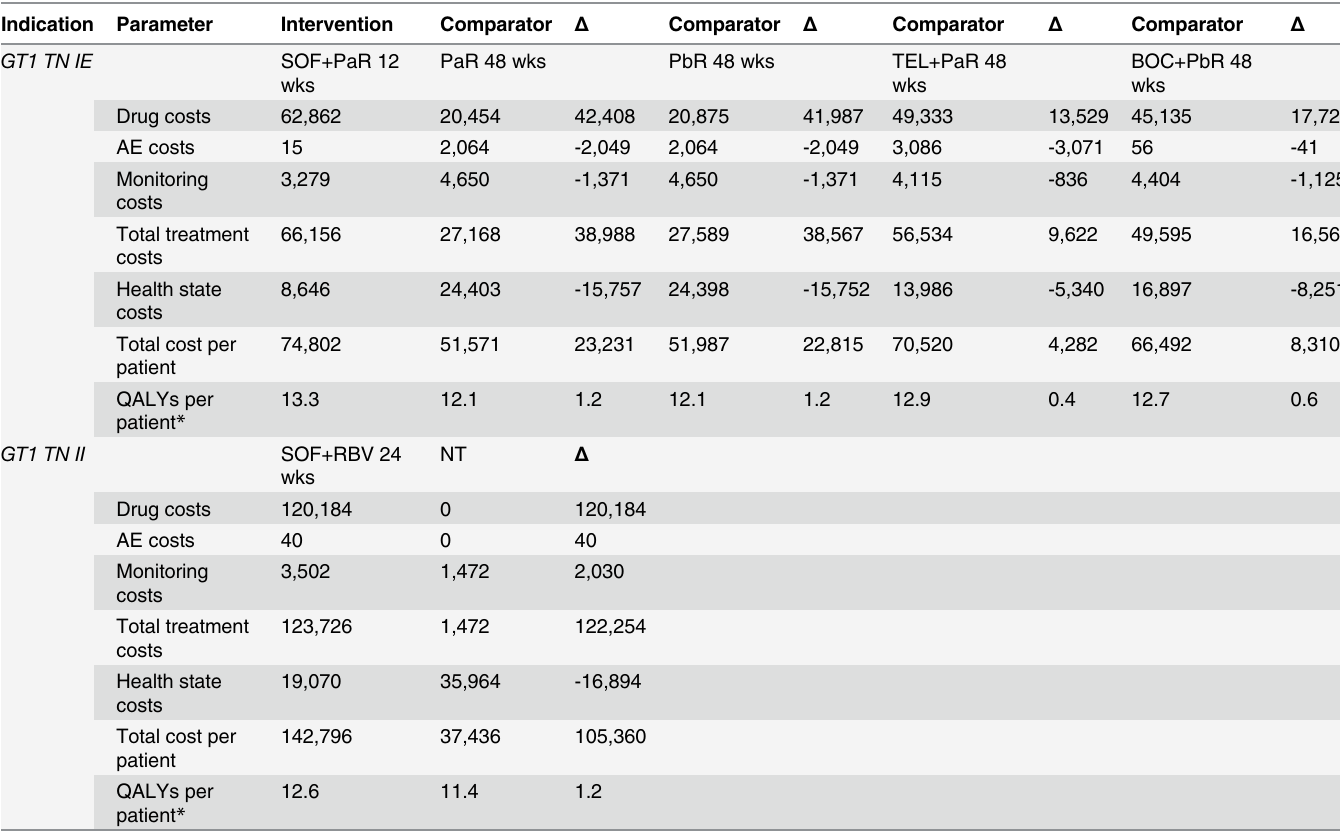
Table 5. Cost (CHF) per patient and cost-effectiveness results in genotype 1.